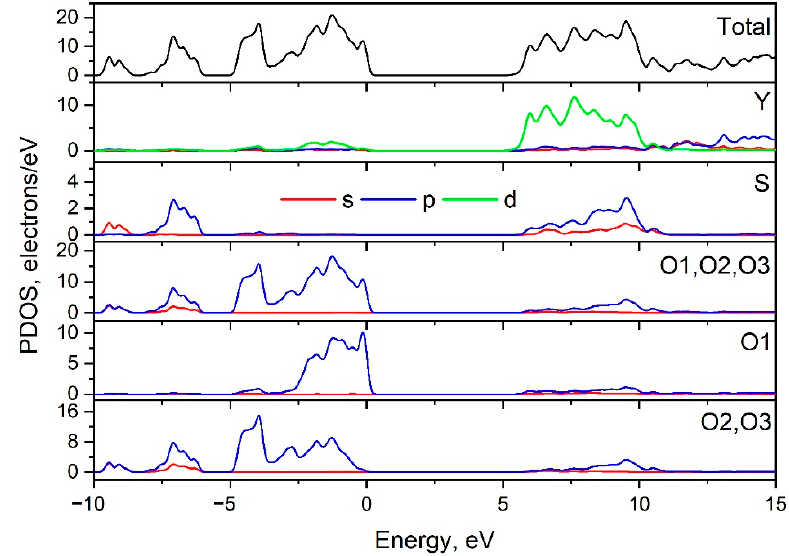
Figure 4. Total and partial density of electronic states of Y 2 O 2 SO 4 .